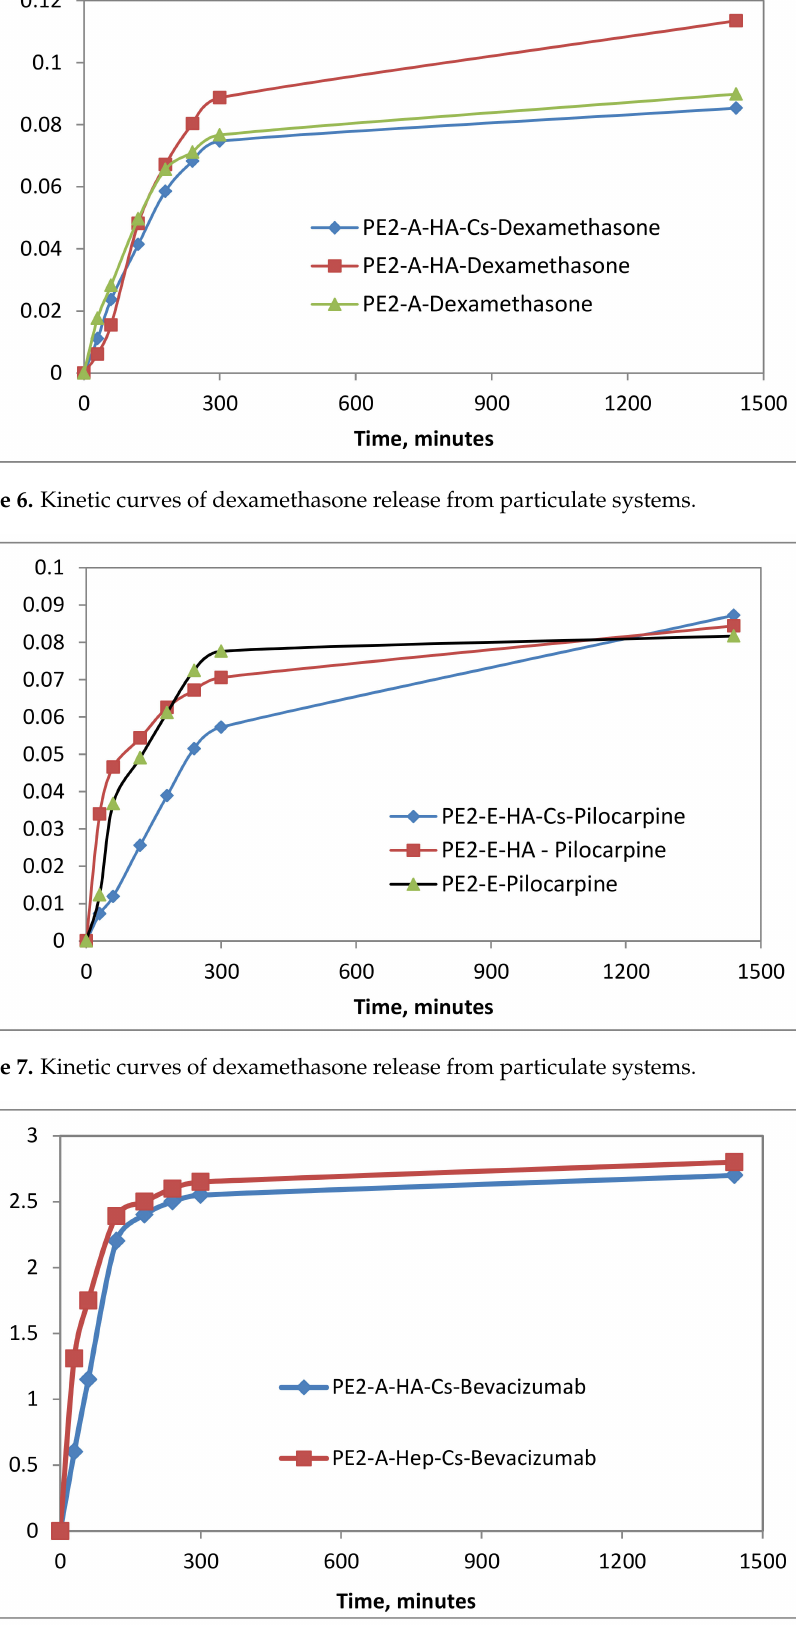
Figure 8. Kinetic curves of Bevacizumab release from particulate